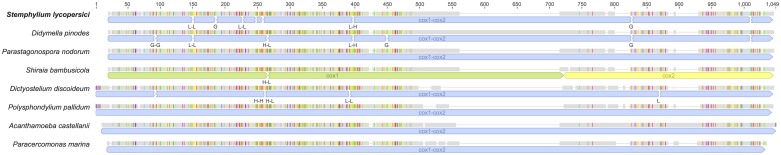
Schematic sequence alignment of COX1 and COX2 with two different gene configurations.Amino-acid identities are highlighted with colors. COX1, COX2 and COX1/2 regions are indicated by green, yellow and blue boxes. Intron positions are represented by a discontinuity in the boxes. Any recognizable homing endonuclease domain, LAGLIDADG domain and/or GIY-YIG domain found within the hypothetical proteins encoded by the intronic ORFs are depicted by the letters H, L and G, respectively. The amino-acid sequences were aligned using MUSCLE with the default settings in Geneious 9.1.2. The detailed alignment is found in S2 Fig.